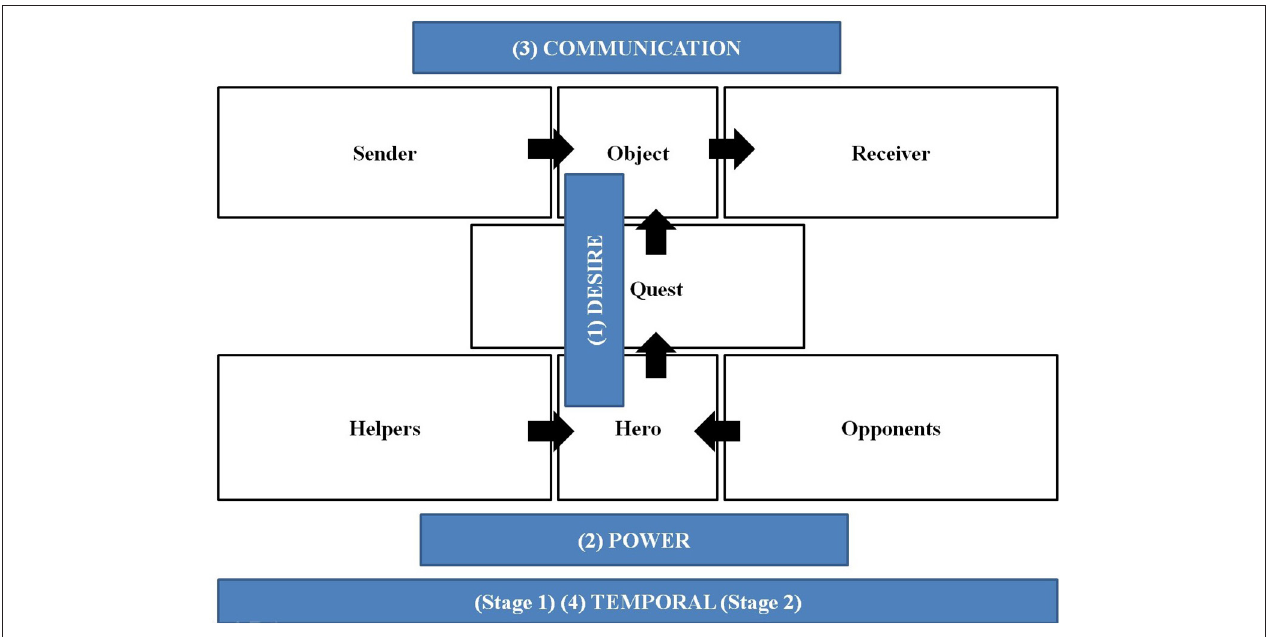
FIGURE 1 | Actantial model and its